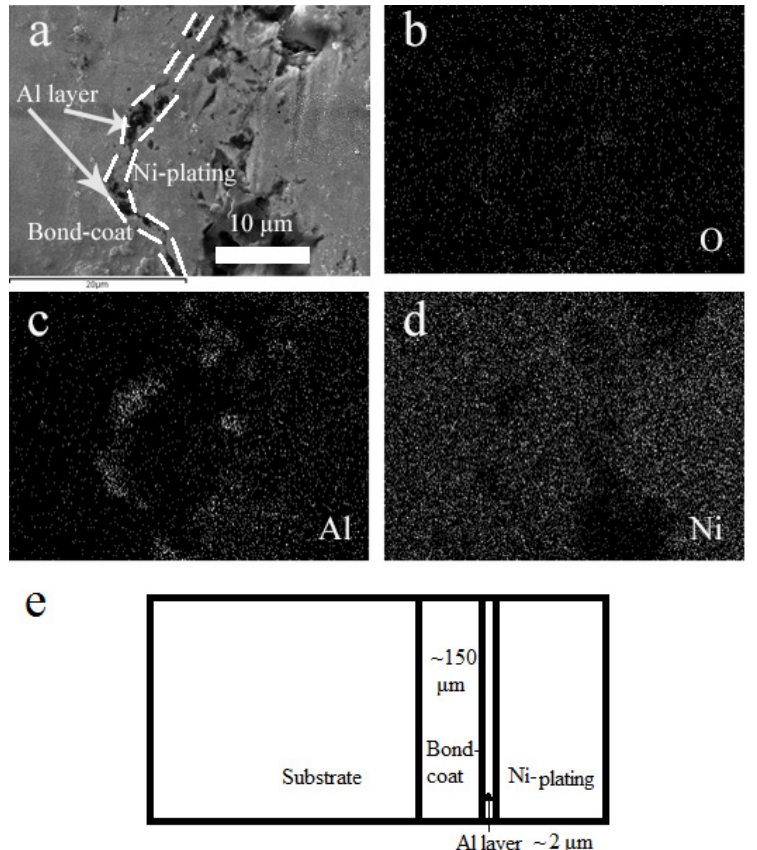
Figure 3. ( a ) Cross-sectional morphology of Al coated bondcoat; ( b ) elemental map contrast of O; ( c ) elemental map contrast of Al; ( d ) elemental map contrast of Ni and ( e ) a schematic of ( a ) showing the layers of the Al coated sample.